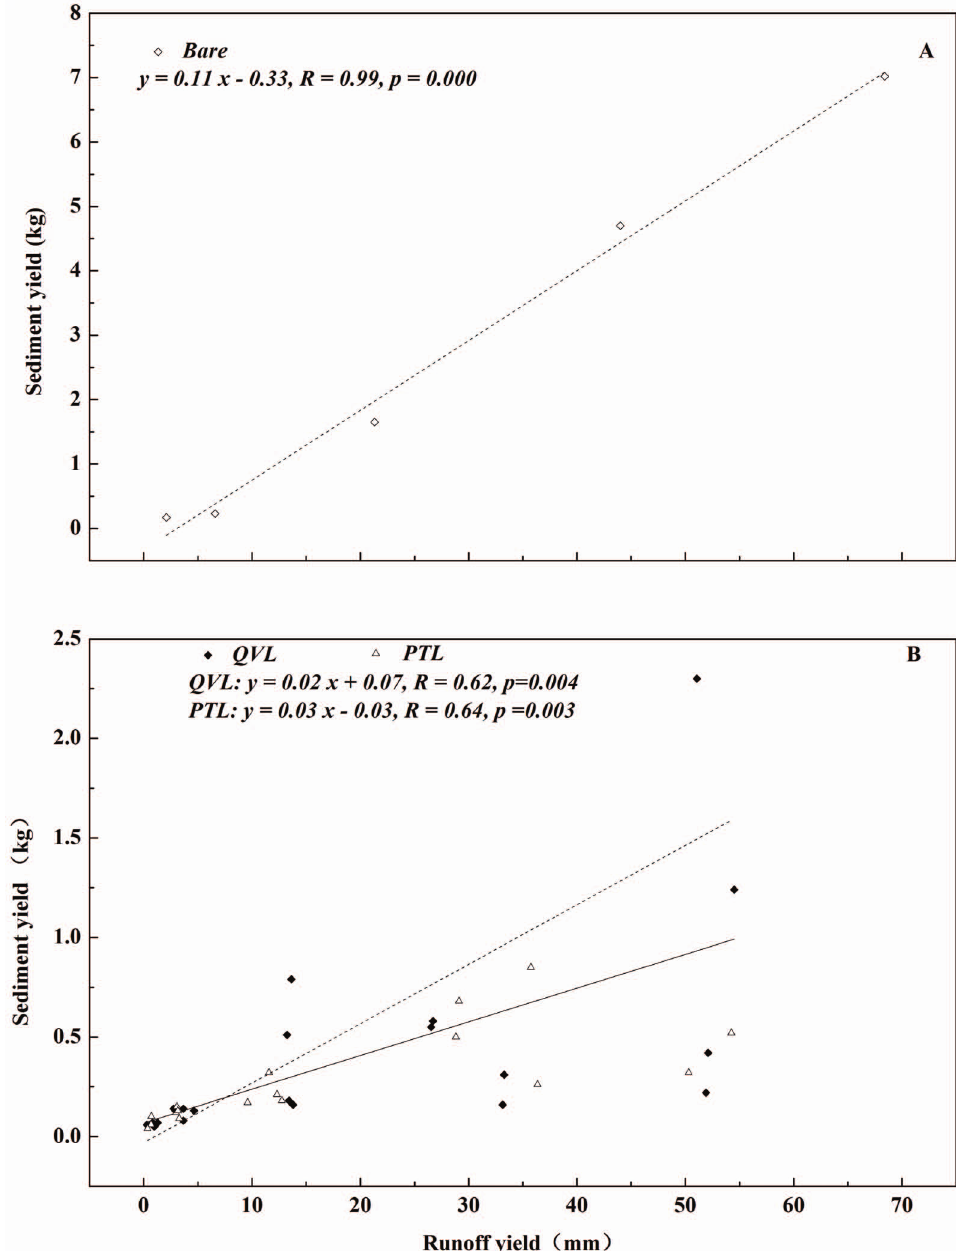
Figure 10. Relationships between runoff yield and sediment yield for bare-soil plots (open diamonds), Quercusvariabilis litter (closed diamonds), and Pinustabulaeformis litter (open